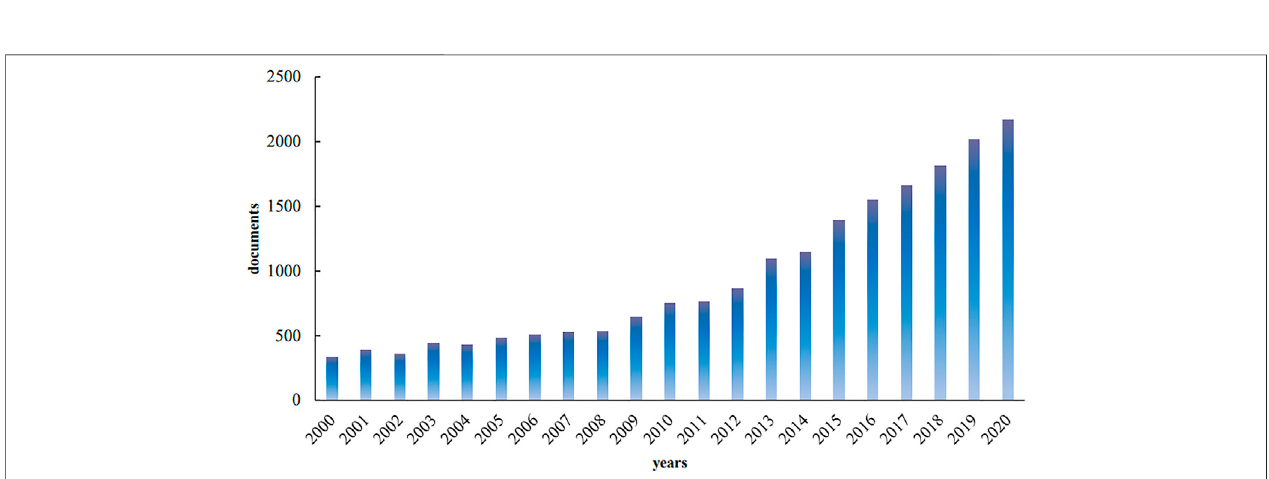
FIGURE 1 | Annual publications of geothermal